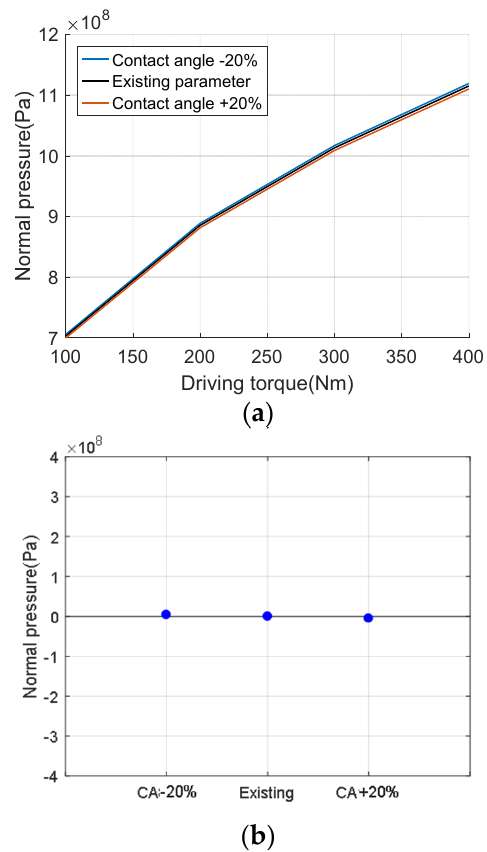
Figure 9. Normal pressure changes with contact angle ( a ) Normal pressure change with respect to driving torque ( b ) Normal pressure change at 400 Nm and 200 rpm.